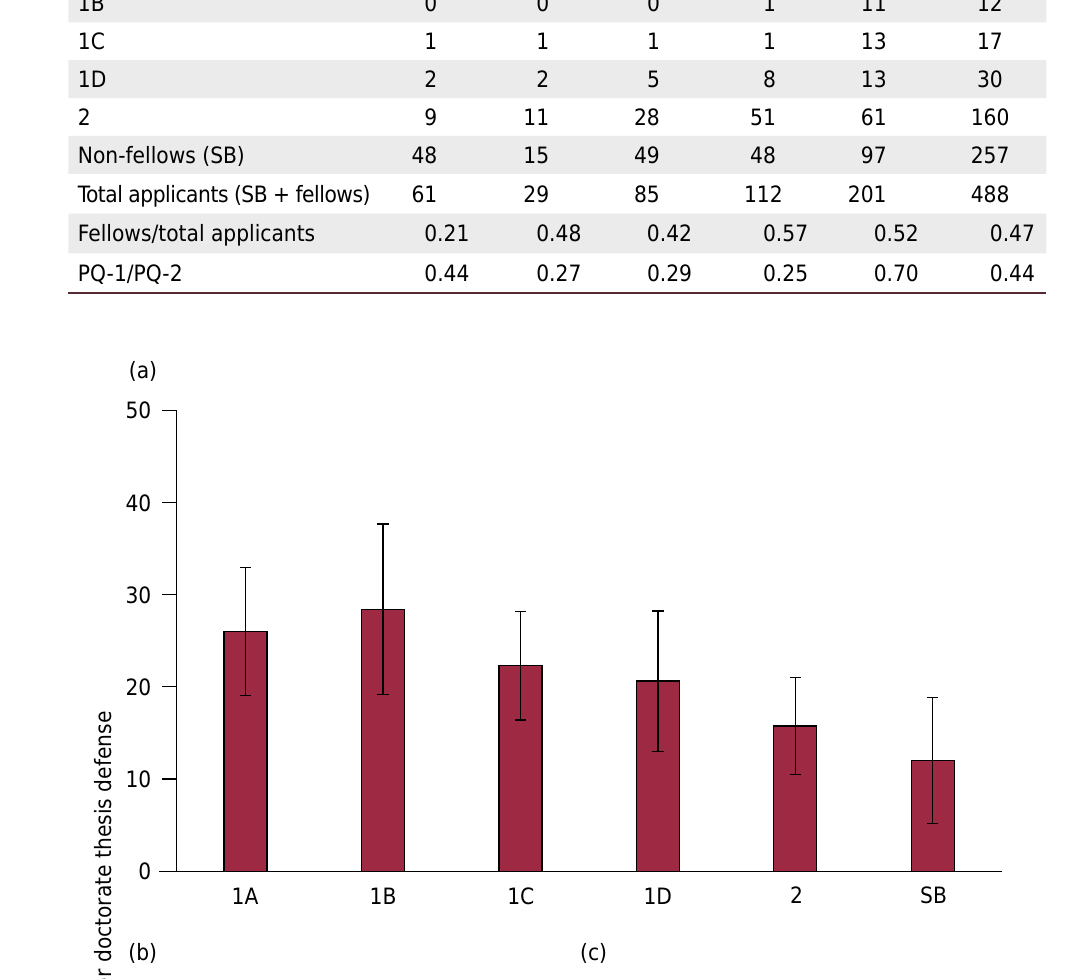
Table 2. Regional distribution of researchers, by fellowship level and number of fellowship holders/ total number of researchers in CNPq Call 2018 Fellowship category/level